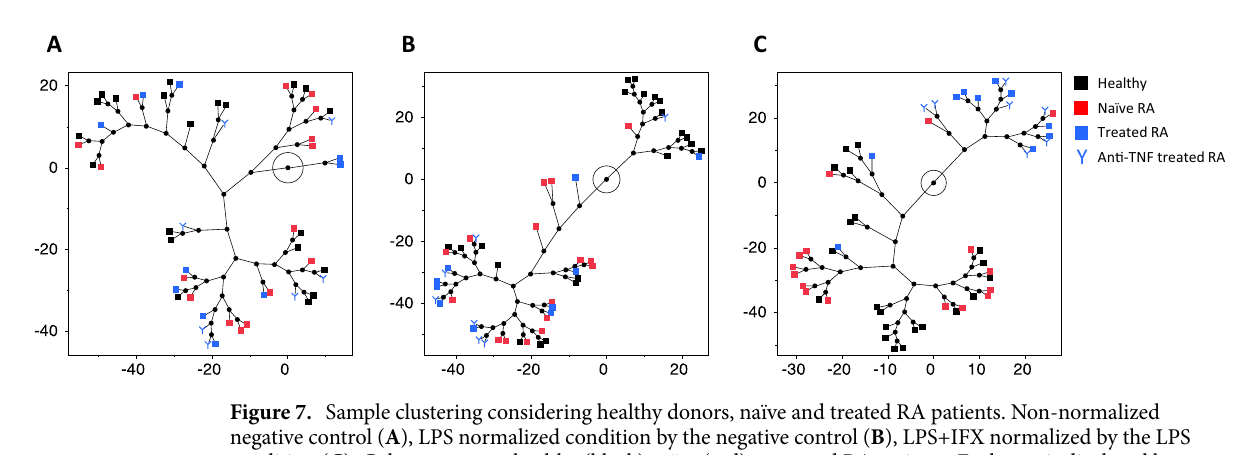
Figure 7. Sample clustering considering healthy donors, naïve and treated RA patients. Non-normalized negative control ( A ), LPS normalized condition by the negative control ( B ), LPS+IFX normalized by the LPS condition ( C ). Colors represent healthy (black) naïve (red) or treated RA patients. Each row is displayed by an end point, and each cluster join is represented by a new point. Lines represent distance between clusters and are relative to each